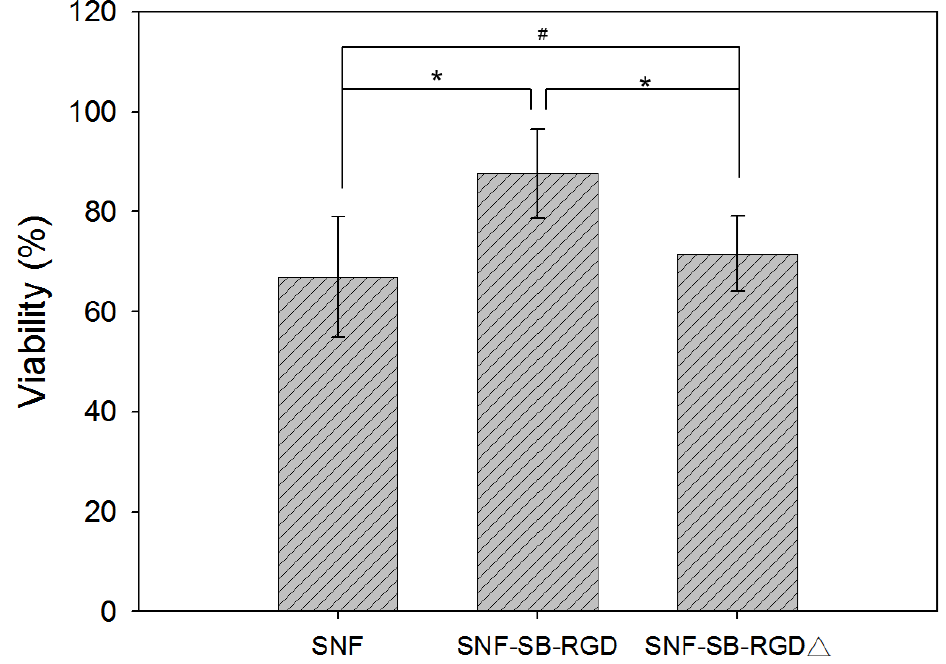
Figure 6. Cell viability comparison between PC12 cells cultured on SNF, SNF-SB-RGD, and SNF-SB-RGD∆ substrates. Assessments were done using the LIVE/DEAD® stain with Ethidium Homodimer-1 and Calcein AM 72 hours after seeding. n = 10 t -test, * p <0.05, # p >